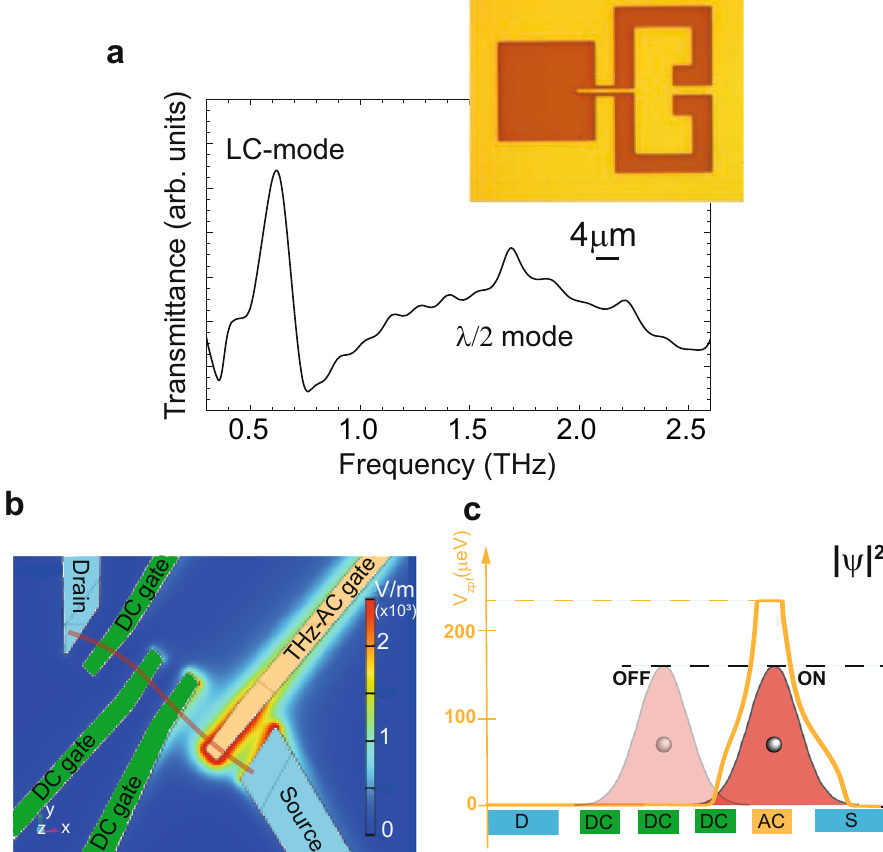
Fig. 2 Cavity characterisation, device geometry and working principle. a Transmittance spectrum of the cavity measured on a reference ensemble, revealing the LC-mode of the cavity at 0.62 THz and a much broader dipolar mode at ca 1.75 THz. Inset: Cavity geometry b Simulation of the electric fi eld distribution at resonance, showing how the LC-mode of the cavity couples to the QD and the strong focusing of the cavity mode on the QD. The LC-mode is found to be at 0.54 GHz, close to the experimental measurement of panel a . c Microwave simulations enriched by a sketch of the electronic wave function in the “ ON ” and “ OFF ” regime explaining how the coupling strength depends on the gate voltage setting of the